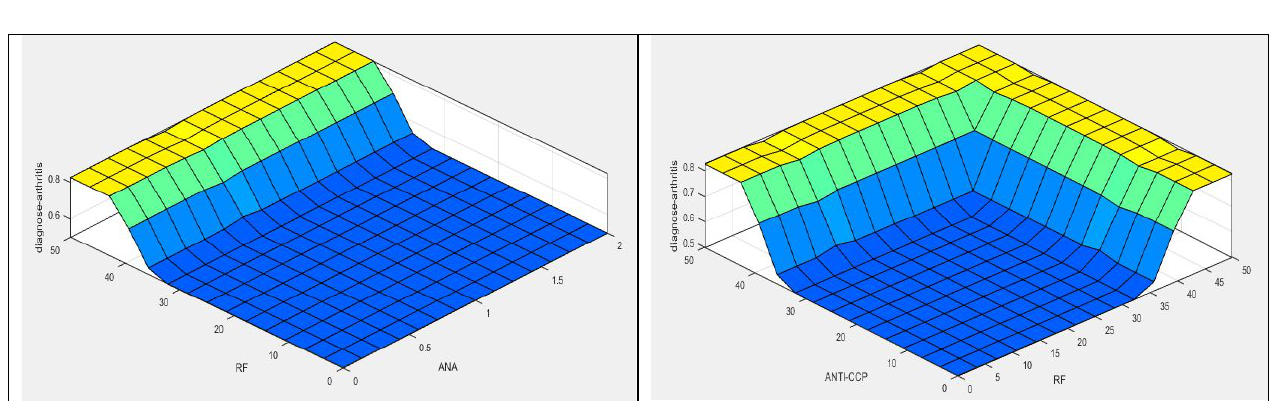
Fig. 6c. Rule Surface for RF and ANA Fig. 6d. Rule Surface for Anti-CCP and RF